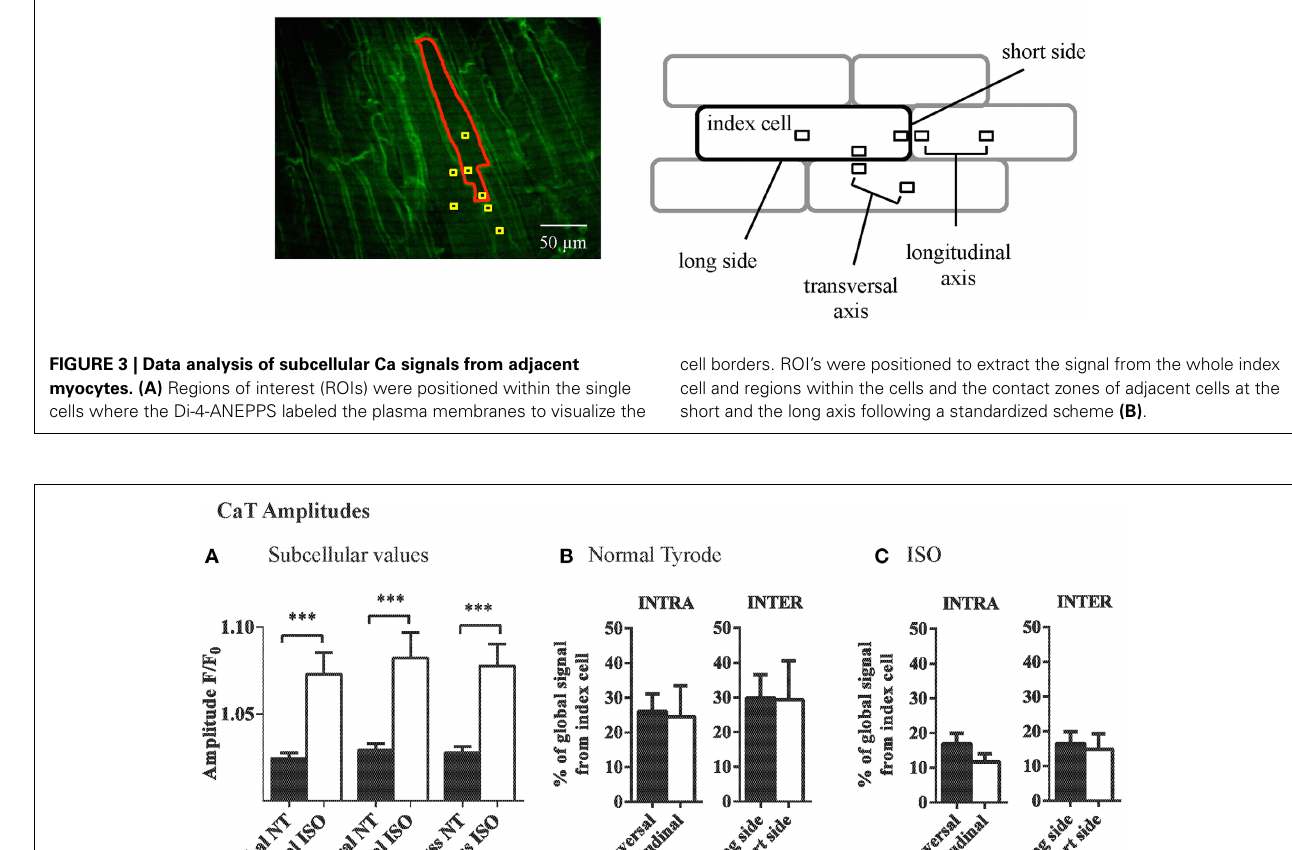
wassignificantlyhigherinthelongitudinalaxiswithinthemyocyte.Intercellular variation in amplitude was similar across the long and short side of the cardiac myocyte and compared to intracellular variation along the short axis. (C) The same overall pattern was found with ISO, where generally the differences between adjacent cells and within cells were smaller. ∗∗∗ p ≤ 0 . 001